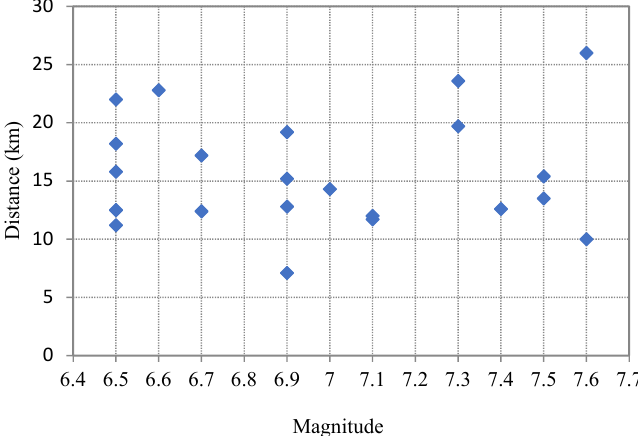
Figure 12. Large-distance distance diagram for selected ground motions.